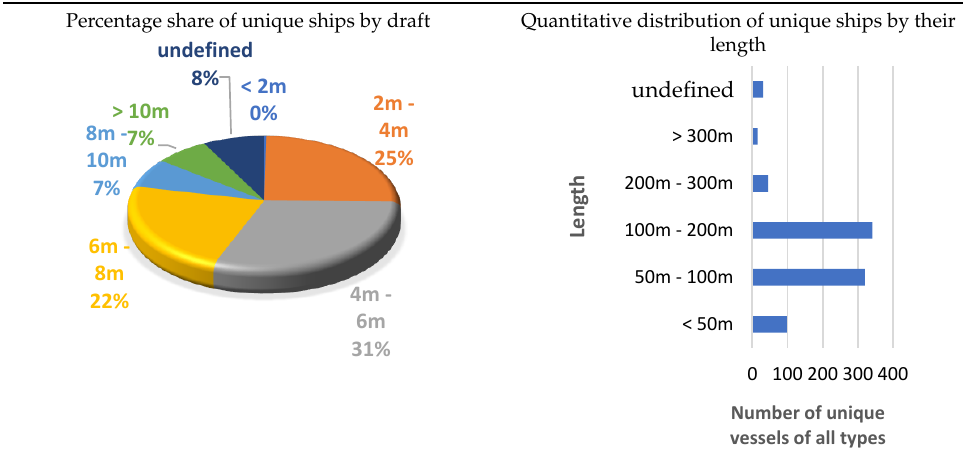
Figure 10 . Vessel traffic intensity of all types in the OWF area plus a 2 Nm buffer (1 ” mesh GRID). Table 8. Qualitative characteristics of all types of ships. Percentage share of unique ships by draft Quantitative distribution of unique ships by their length